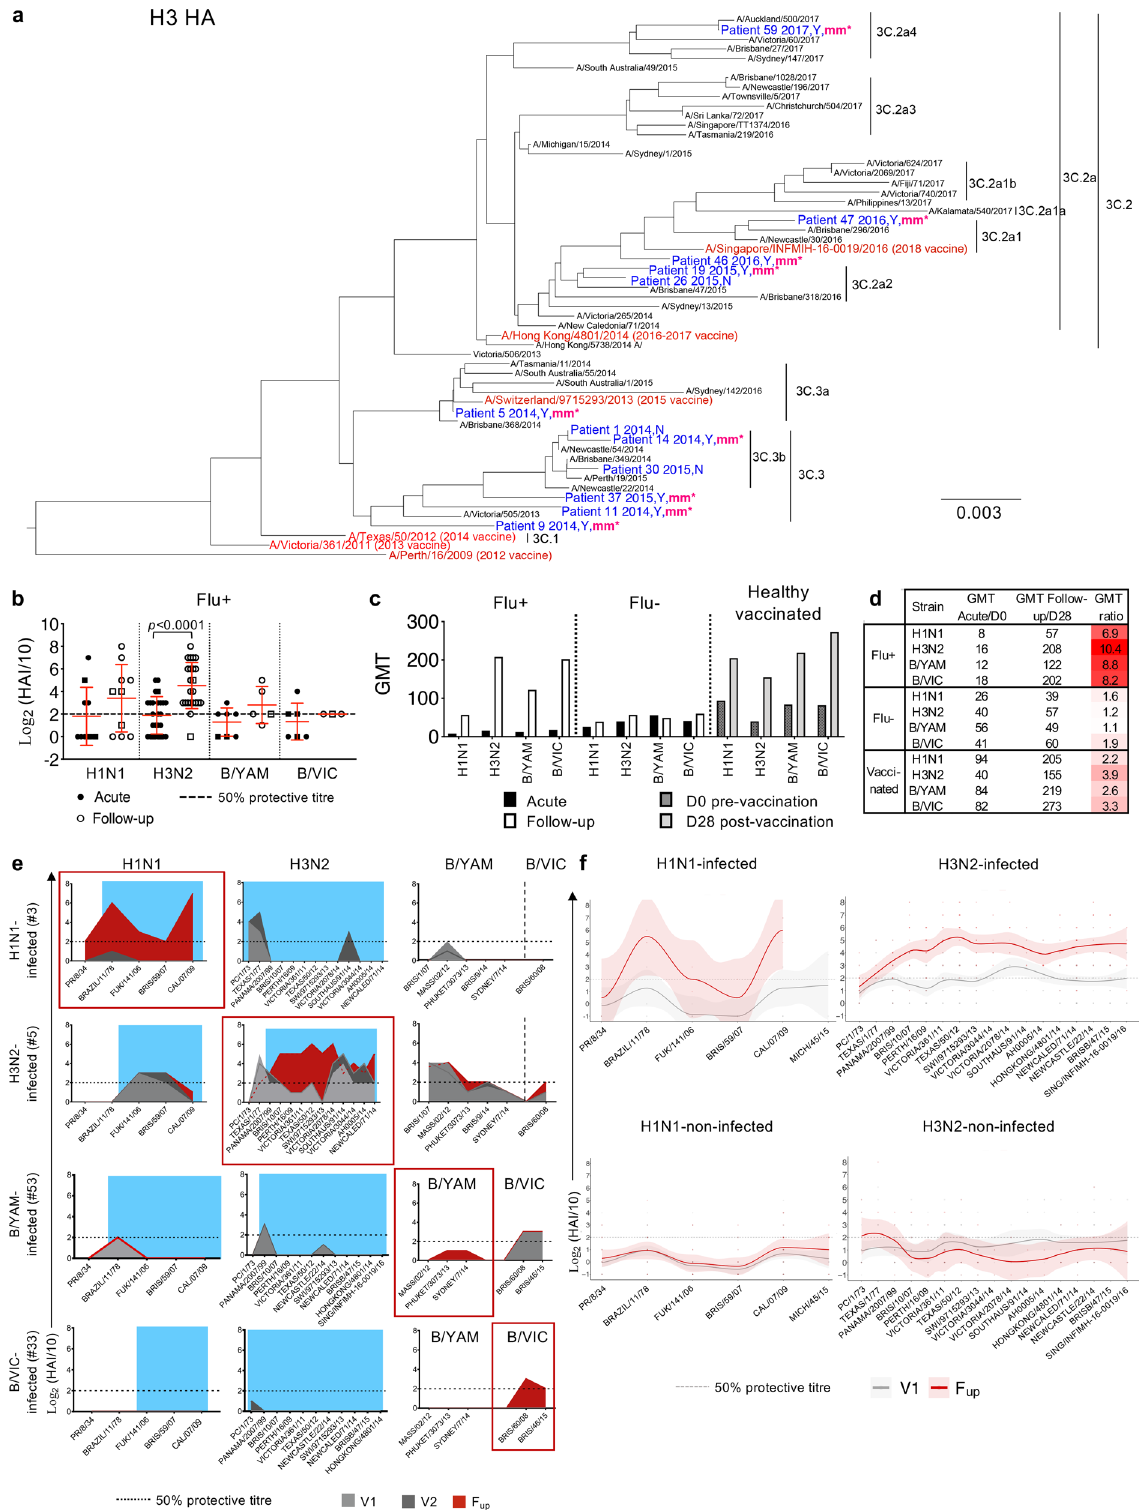
0.0017, Tukey ’ s multiple comparison test), before becoming more CD21 hi CD27 hi resting memory at follow-up compared to acute timepoints (H3: p = 0.0004, B: p < 0.0001, Tukey ’ s multiple comparison test) (Fig. 3c, e top panels). Conversely, in a healthy vaccinated cohort, the resting memory phenotype was most prominent at baseline, before becoming more activated memory from days 7-28 following IIV (Fig. 3f, top panel). The